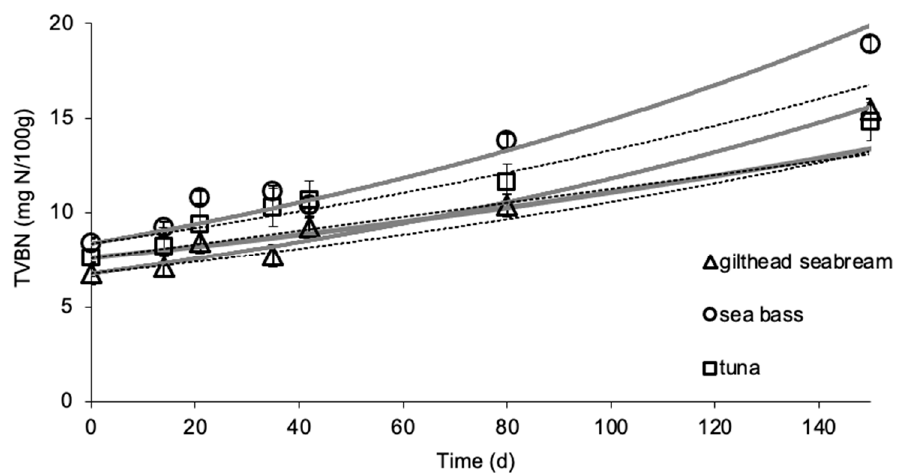
Figure 5. Comparison of experimental and predicted changes in the TVBN of gilthead sea bream fillets, sea bass fillets and yellowfin tuna slices at the temperature profile of the non-isothermal experiment. The gray solid lines indicate predictions by Method #1, the black dashed lines indicate predictions by Method #2, and the data points present the experimental values. (Error bars indicate standard error of measurements of two different samples.)